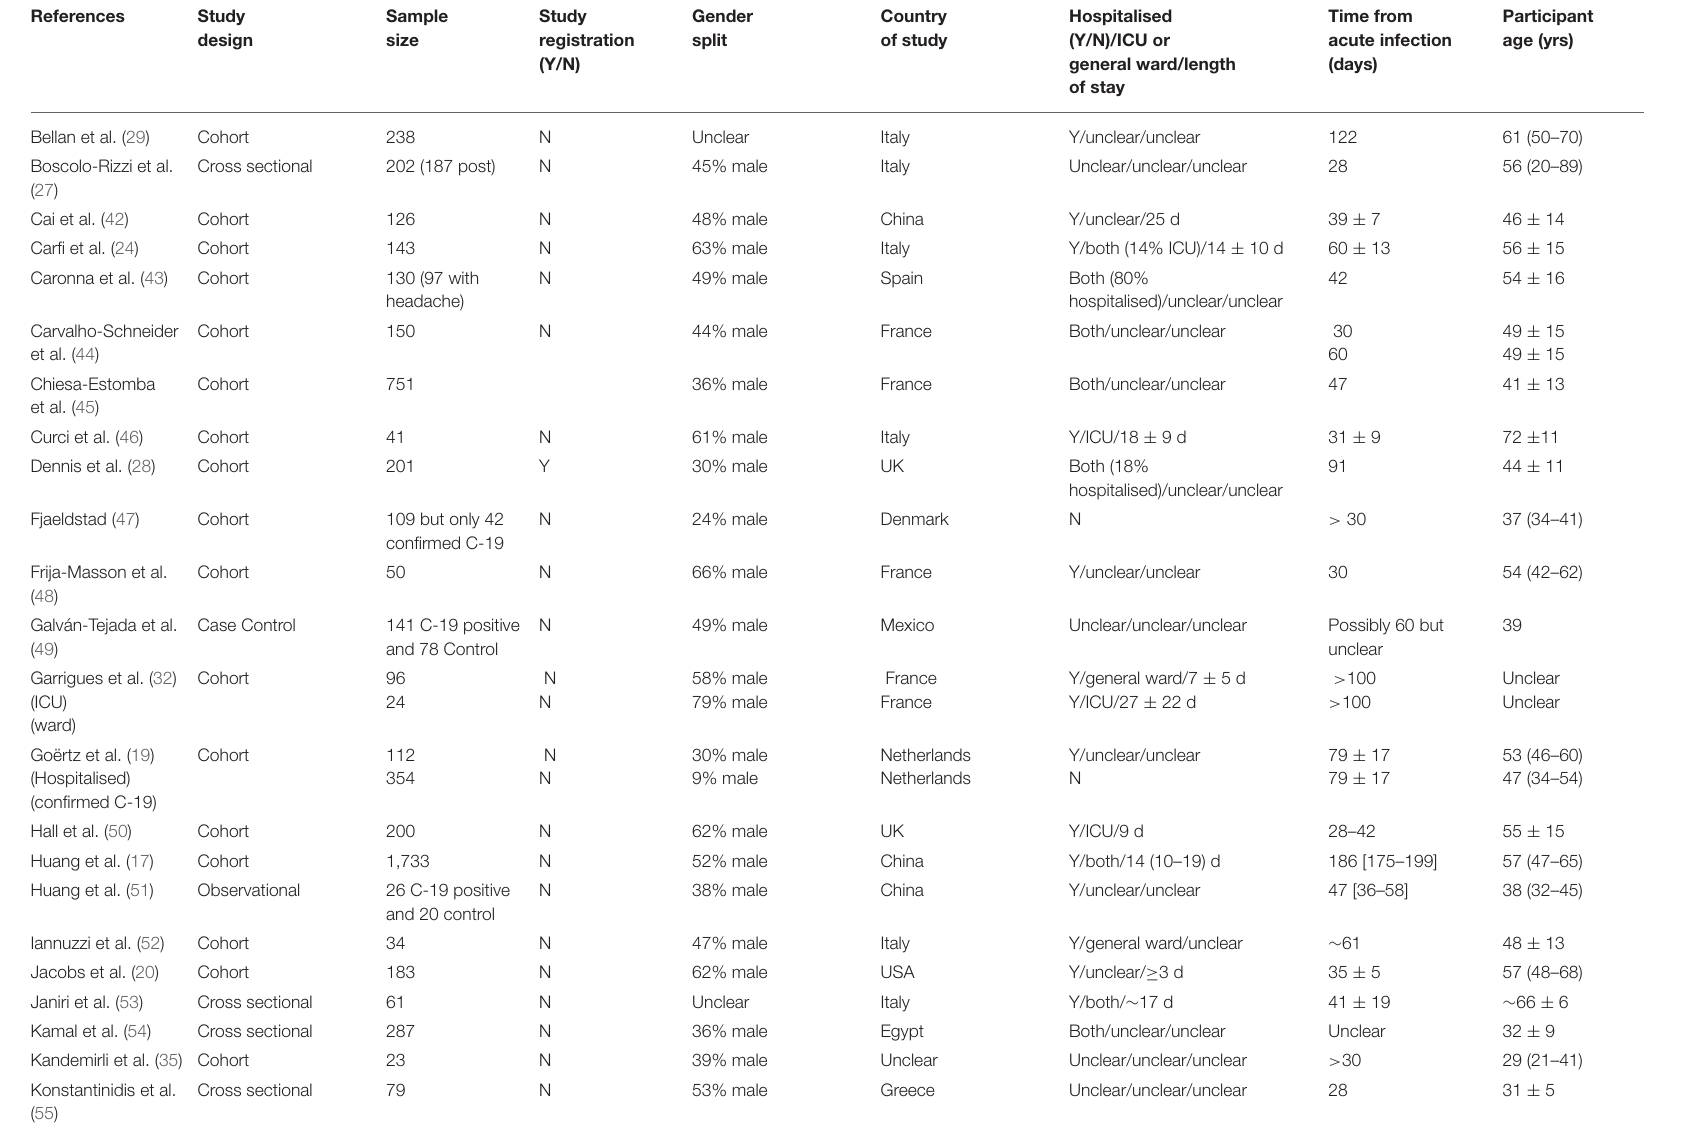
TABLE 1 | General study information of studies concerning long COVID